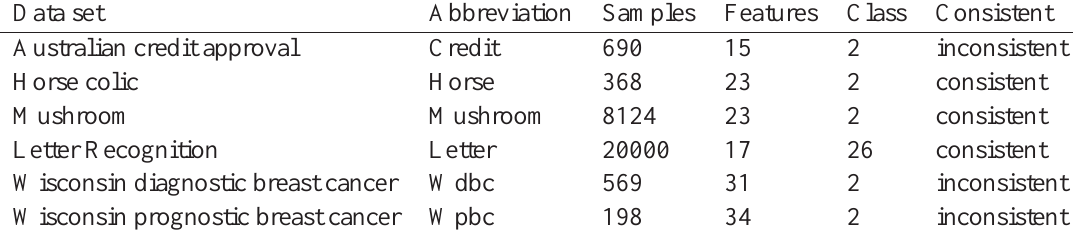
Table 7: The raw data sets from